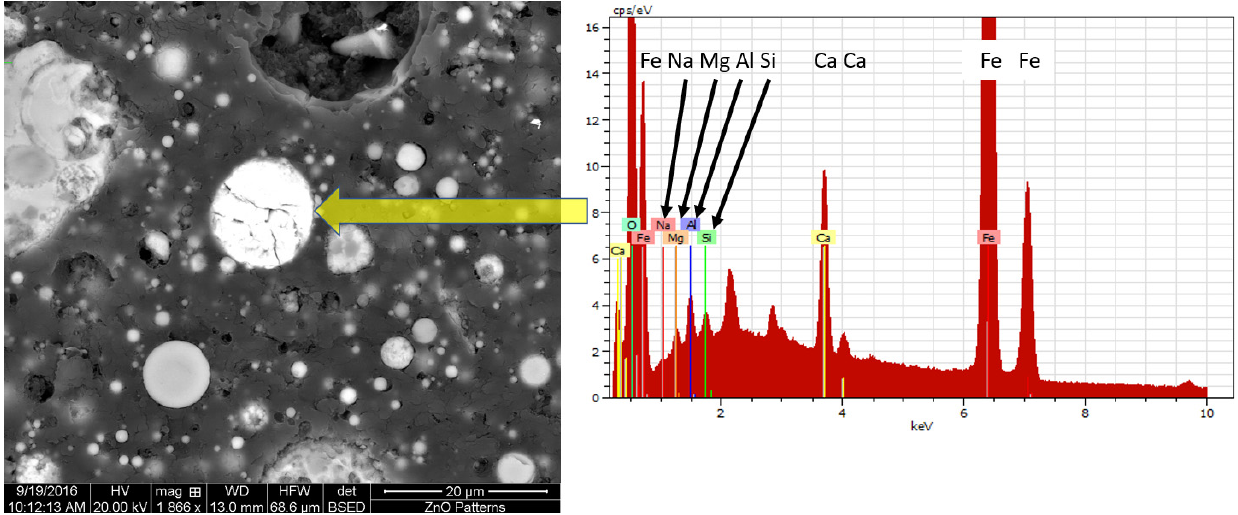
Figure 3. Left/ Back-scatter image of Fe-rich grain. Scale = 20 μ m. Right/ EDS spectrum of elemental composition of large particle. Signals for Au and Pd (not labeled on this figure; see Figures 1 and 2) are extraneous to the sample.